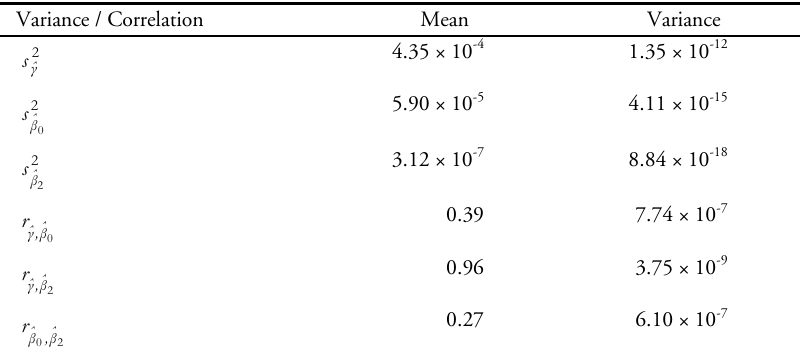
Monte Carlo indices of the variance-covariance matrix V ˆ based on 10 4 samples. The interest is focused on the upper-left 3 (cid:117) 3 part of V ˆ , that is